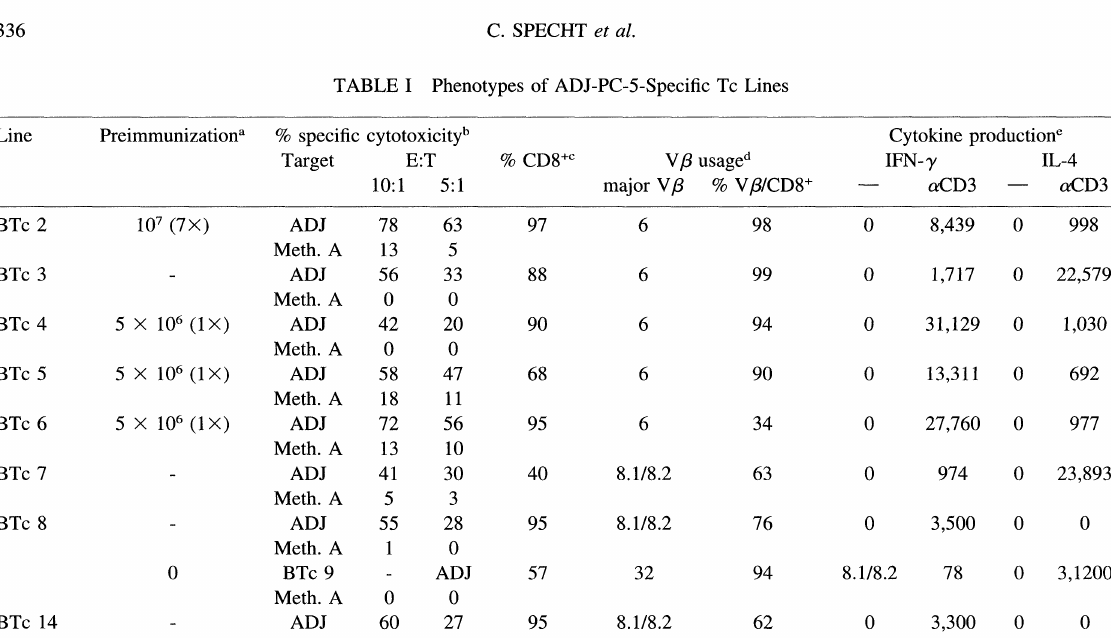
Phenotypes of ADJ-PC-5-Specific Tc